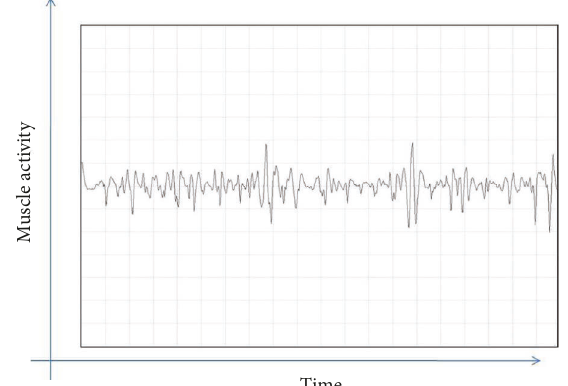
Figure 3: Electromyography recording of OSMF patients before treatment.